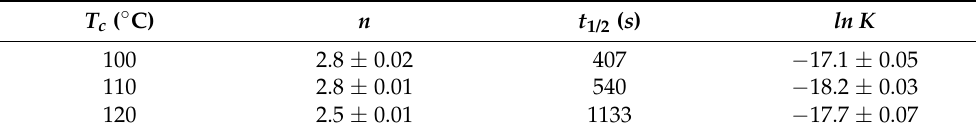
Table 1. Isothermal crystallization parameters of PLLA.